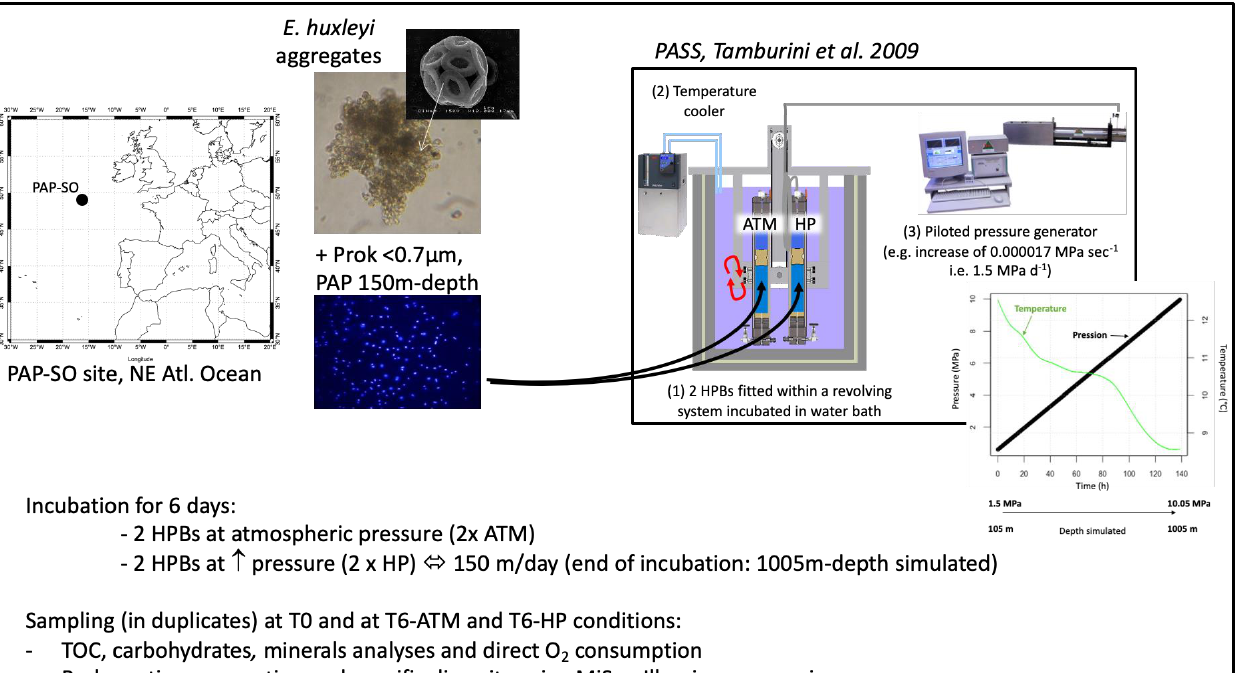
Figure 1. Schematic design of the sinking particles simulation (SINPAS) experiment. The objective of the present study was to investigate the effect of increasing hydrostatic pressure on the degradation of Emiliania huxleyi aggregates by NE Atlantic natural free-living prokaryotic assemblages collected at 105 m depth (PAP site). Using the particles sinking simulator system (PASS described in Tamburini et al. [34]), incubations were performed in duplicates for over 6 days under constant atmospheric pressure (ATM) or controlled increasing pressure conditions (HP) simulating a sinking rate of 150 m d −1 . Both ATM and HP conditions were submitted to a decrease in temperature mimicking profiles measured in situ by CTD (see plot temperature and pressure versus time). Global O 2 consumption was real-time monitored inside the high-pressure bottles using planar optodes via a sapphire window in both ATM and HP conditions. Three data sets were therefore obtained: initial time (T0), and after 6 days of incubation T6-HP and T6-ATM. The differences between T0 and T6-HP were due to the fate of E. huxleyi aggregates, the decrease in temperature, and the increase in hydrostatic pressure, those between T0 and T6-ATM were due to the fate of E. huxleyi aggregates and the decrease in temperature, and those between T6-HP and T6-ATM were due only to the increase in hydrostatic pressure.